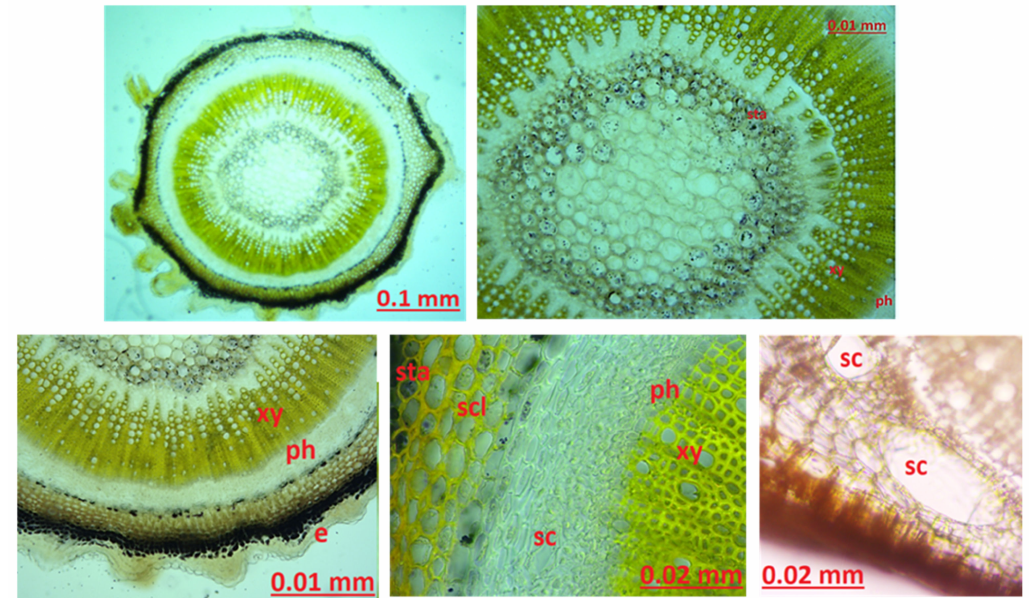
Figure 2. The stem anatomy of Hypericum scabrum ; sc: secretory canals, ph: phloem, xy: xylem, scl: sclerenchyma, e: epidermis, sta: starch. Leaf cross-section